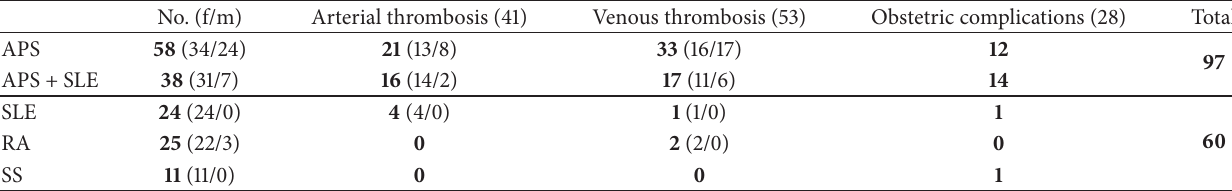
Table 1: Prevalence of arterial thrombosis, venous thrombosis, and obstetric complications in the groups of selected autoimmune patients.